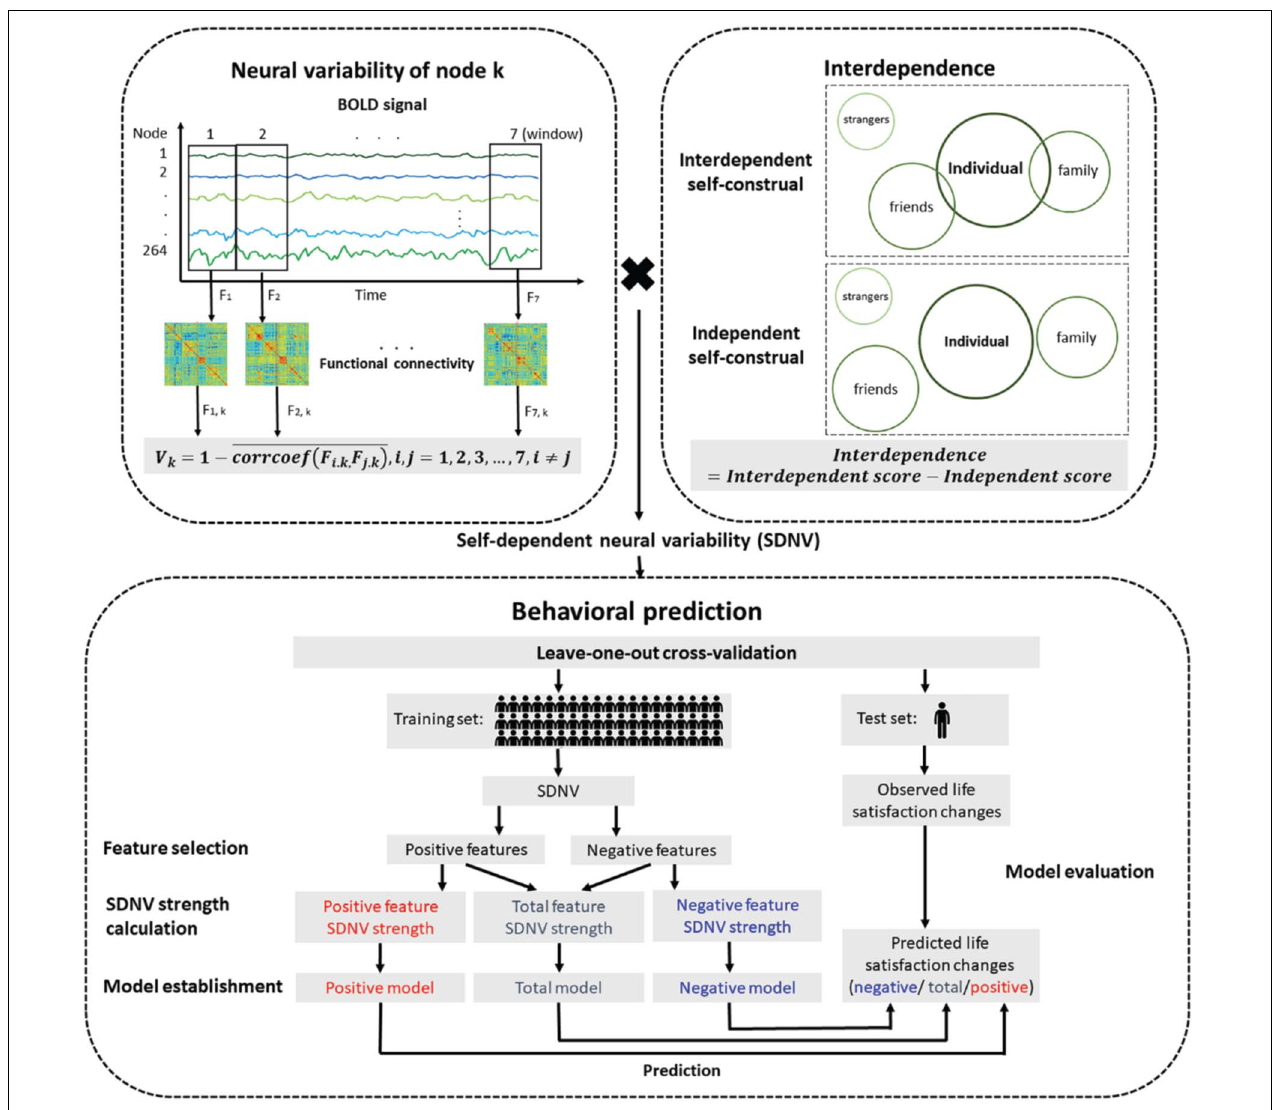
FIGURE 1 | Flow chart of the prediction analysis. The neural variability of a node was the temporal variability of functional connectivity between the node and all nodes across the whole brain. Interdependent self-construal was the difference in the mean score between the interdependent self-construal subscale and the independent self-construal subscale. The self-dependent neural variability (SDNV) of a node was the interaction (i.e., dot product) between the neural variability of the node and interdependent self-construal. The leave-one-out cross-validation method was used to study whether SDNV could predict life satisfaction